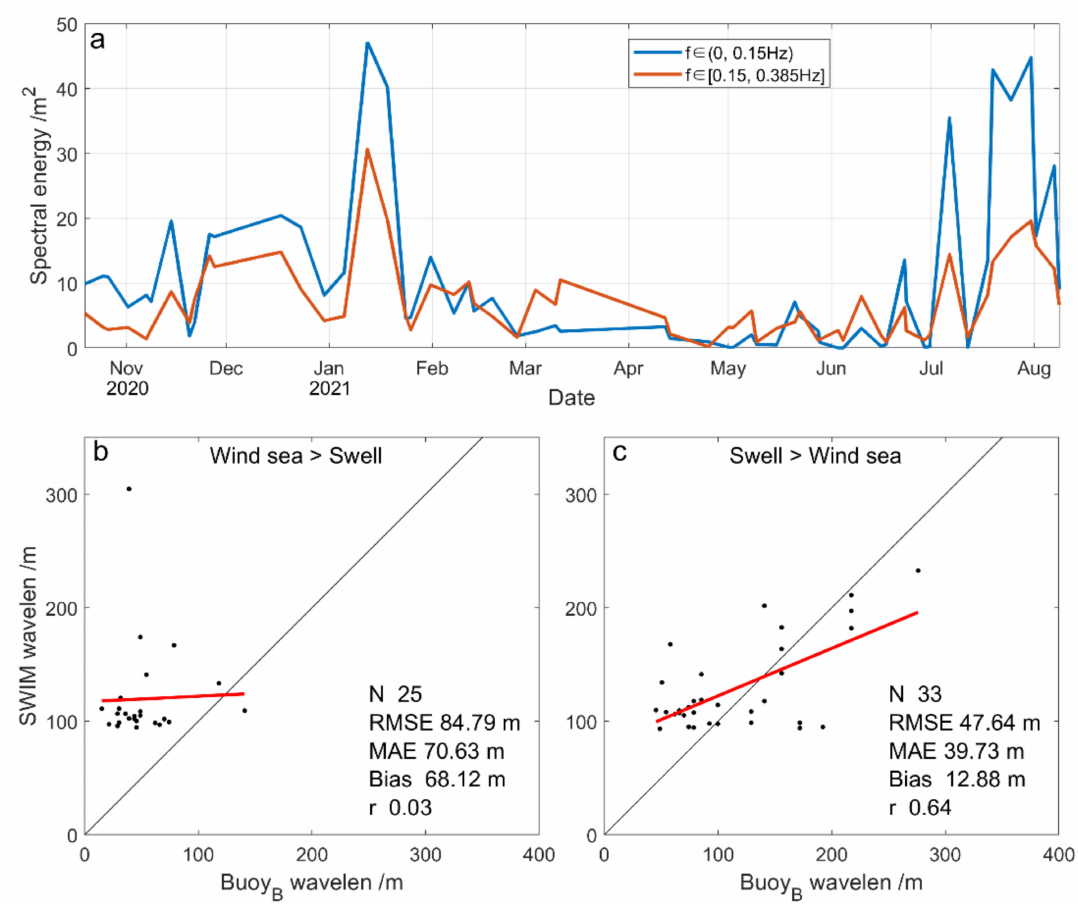
Figure 3. Comparisons of dominant wavelengths from buoy B and CFOSAT SWIM at different sea states; ( a ) shows the observed series of spectral energy of wind sea and swell, assuming 0.15 Hz is their frequency threshold; ( b , c ) are the scatterplots comparisons of dominant wavelengths when wind sea and swell dominates,